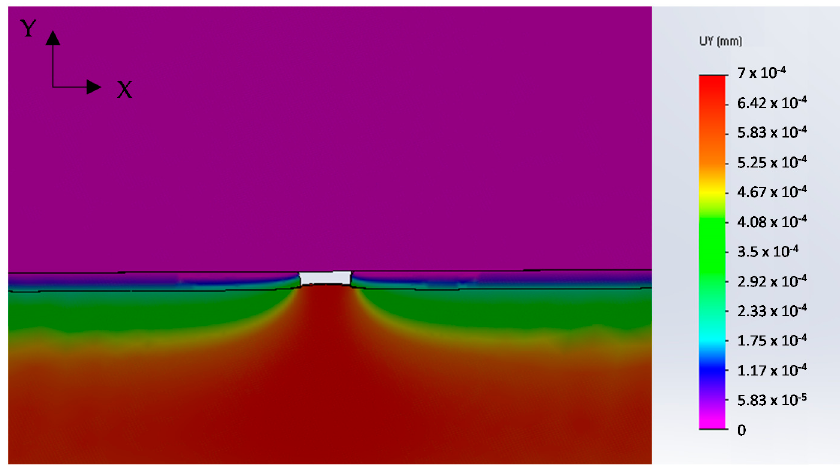
Figure 7. FEM simulations results: Y-displacements distribution.